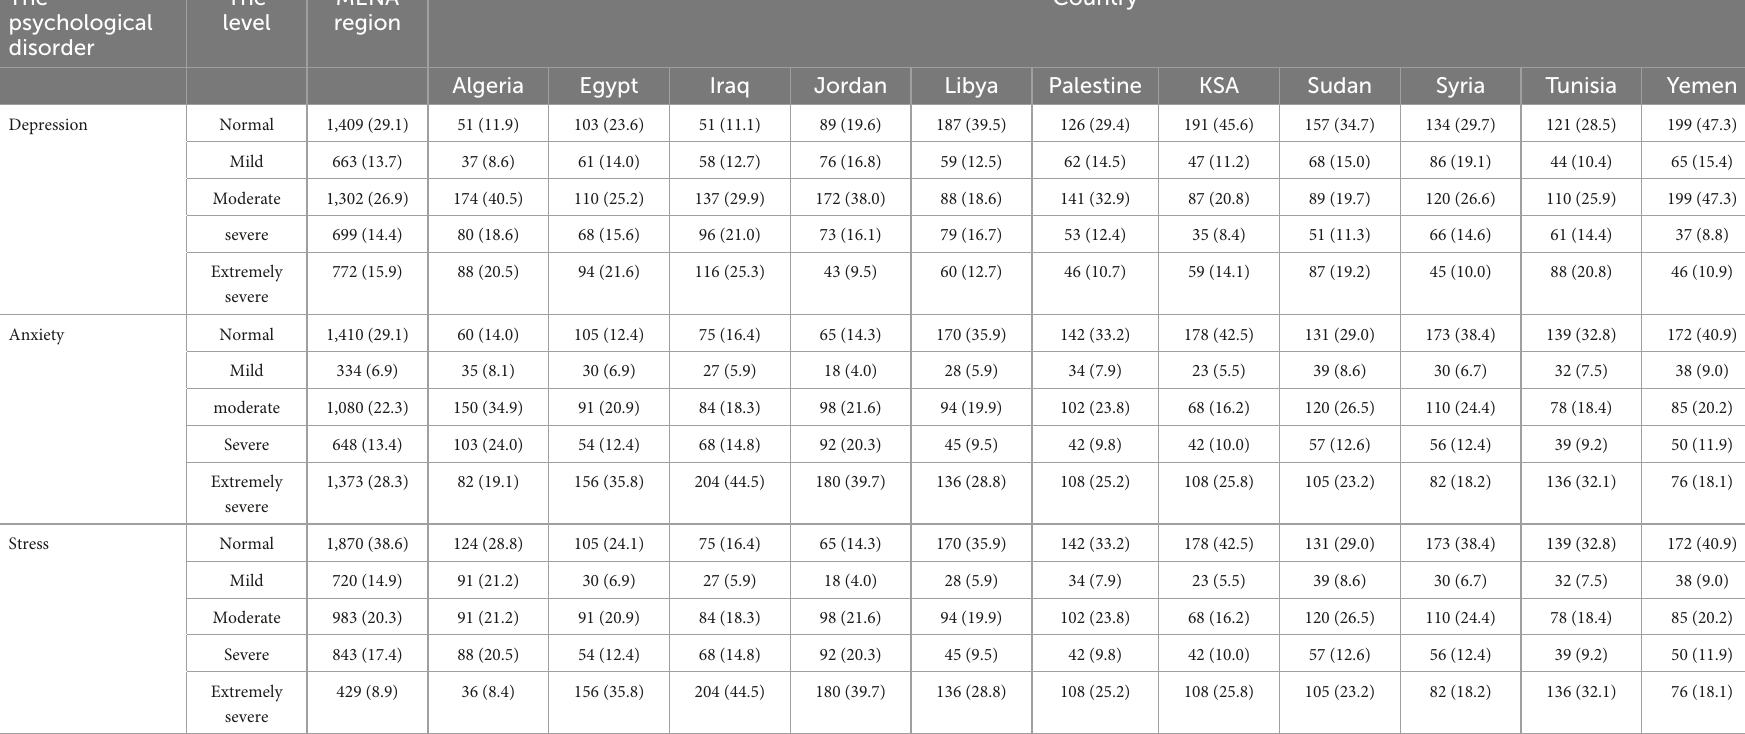
TABLE 4 The prevalence of depression, anxiety and stress levels among the healthcare workers in the MENA region. The